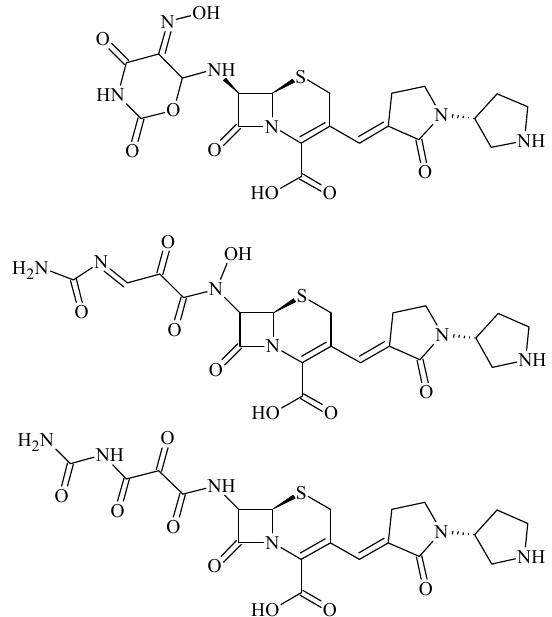
Figure 11. Possible structural formulas proposed for ADP-2. ADP-3, present in the form of two isomers of m/z 479.1348 and 479.1342, can be described as [C 19 H 22 N 6 O 7 S + H] + , which in turns equals ADP-2 minus the CO moiety. The fragment ions of m/z 365 and below are the same as in the case of ceftobiprole (Figure S1F), which again indicates that the reaction takes place in the aminothiadiazole ring.